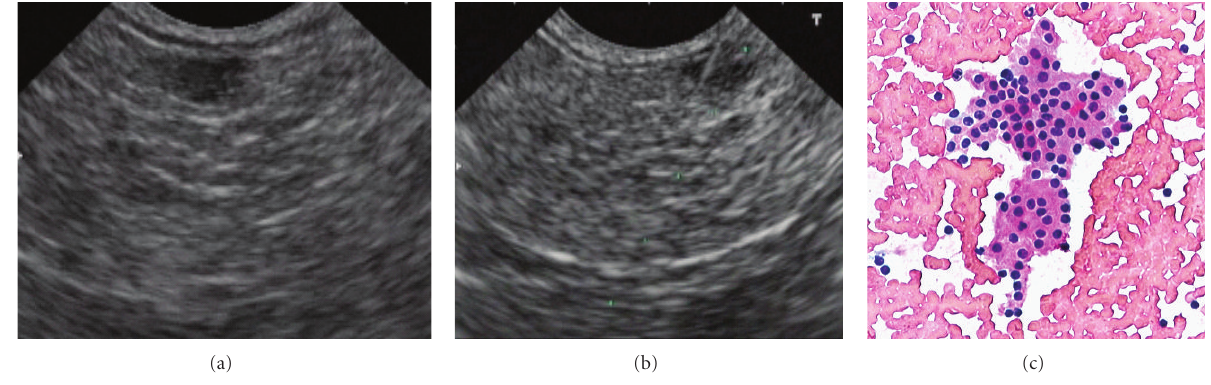
Figure 1: EUS (a), FNA (b), and cytological (c) images of the neuroendocrine pancreatic tumor.